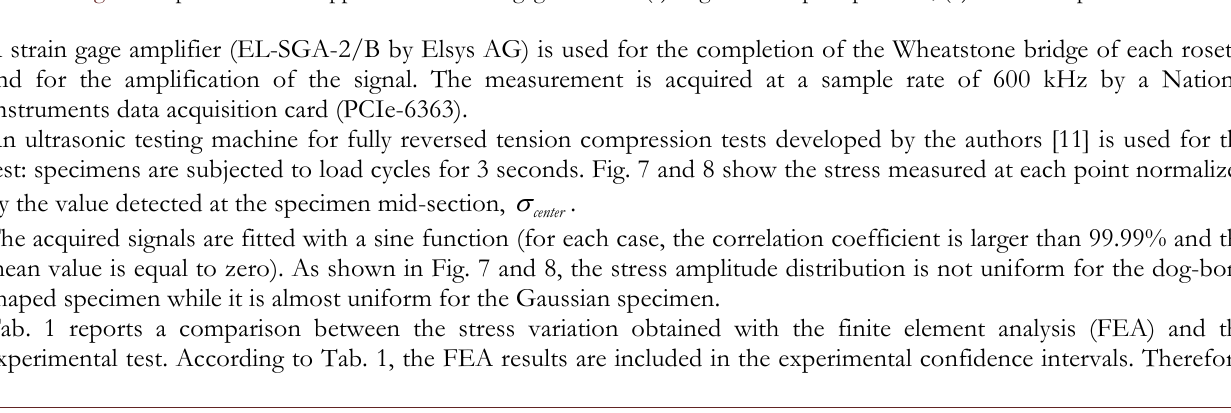
Figure 6: Specimens after application of strain gage rosettes: (a) dog-bone shaped specimen; (b) Gaussian